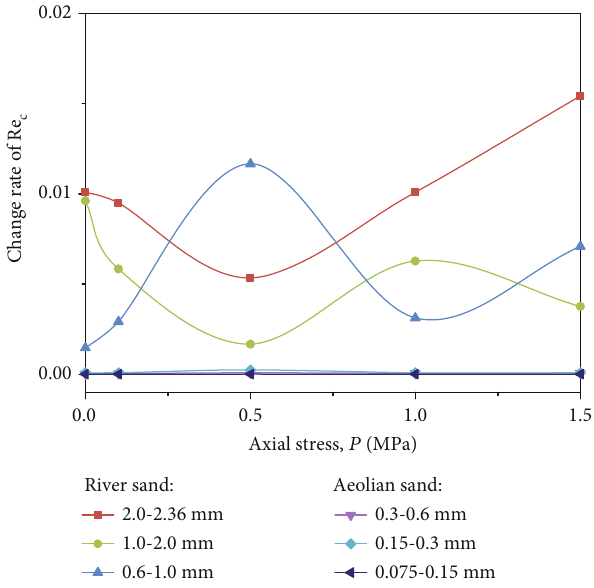
Figure 10: E ff ect of axial stress on critical Reynolds